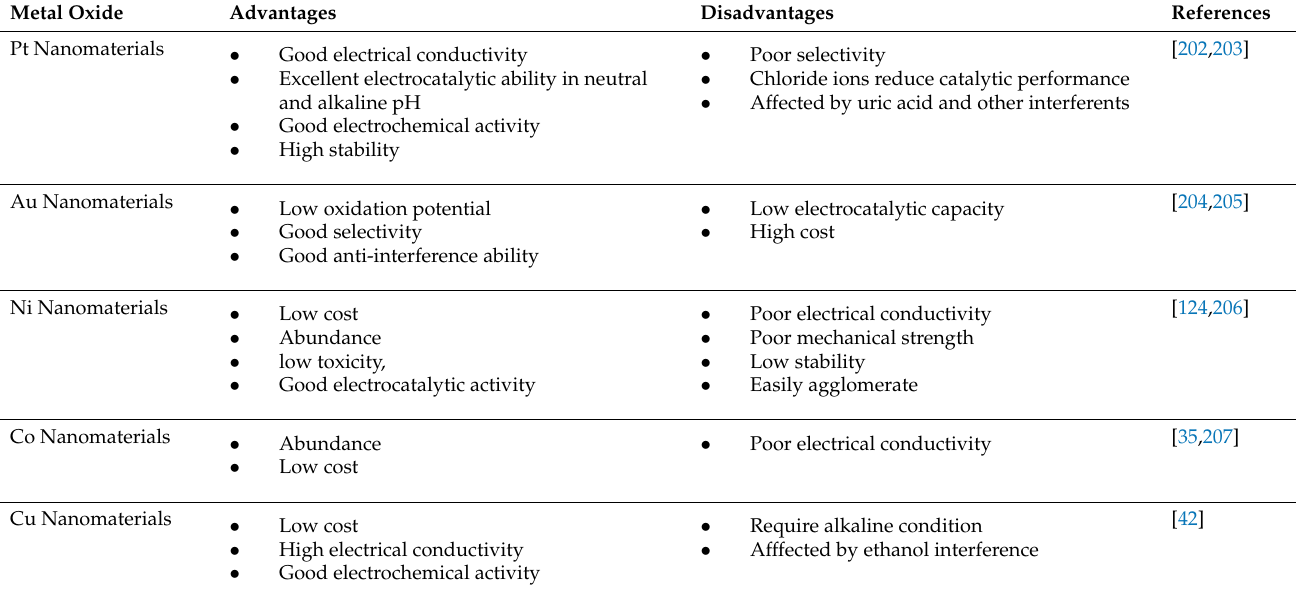
Table 6. Metal nanomaterials advantages and disadvantages for modification of electrodes for non-enzymatic glucose